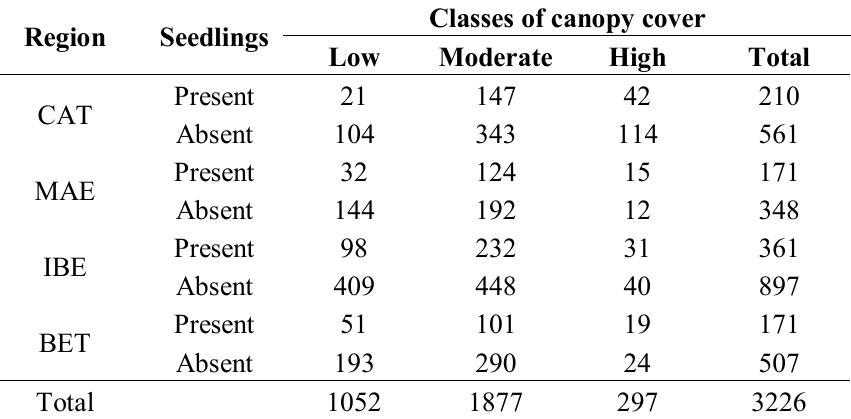
Table 3. Contingency table of the seedling frequencies of Pinus nigra subsp. salzmannii in the four study regions. Low (canopy cover < 55%); Moderate (55% ≤ canopy cover ≤ 80%); High (canopy cover > 80%).